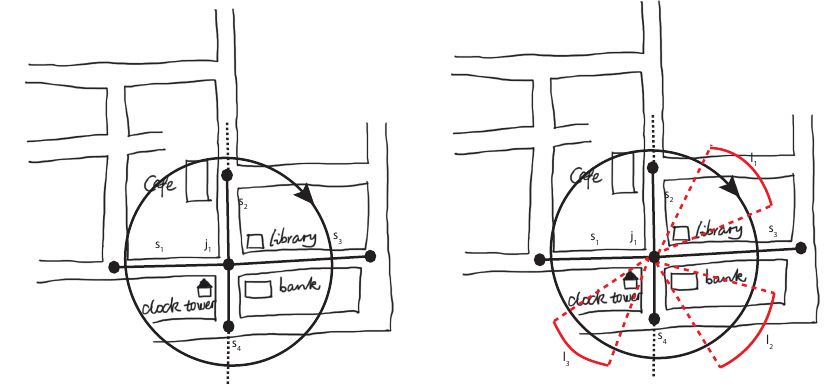
Figure 5: Examples of measuring cyclic order of street segments only (left) and both street segments and landmarks (right): l 1 , l 2 and l 3 represent library, bank and clock tower, re-